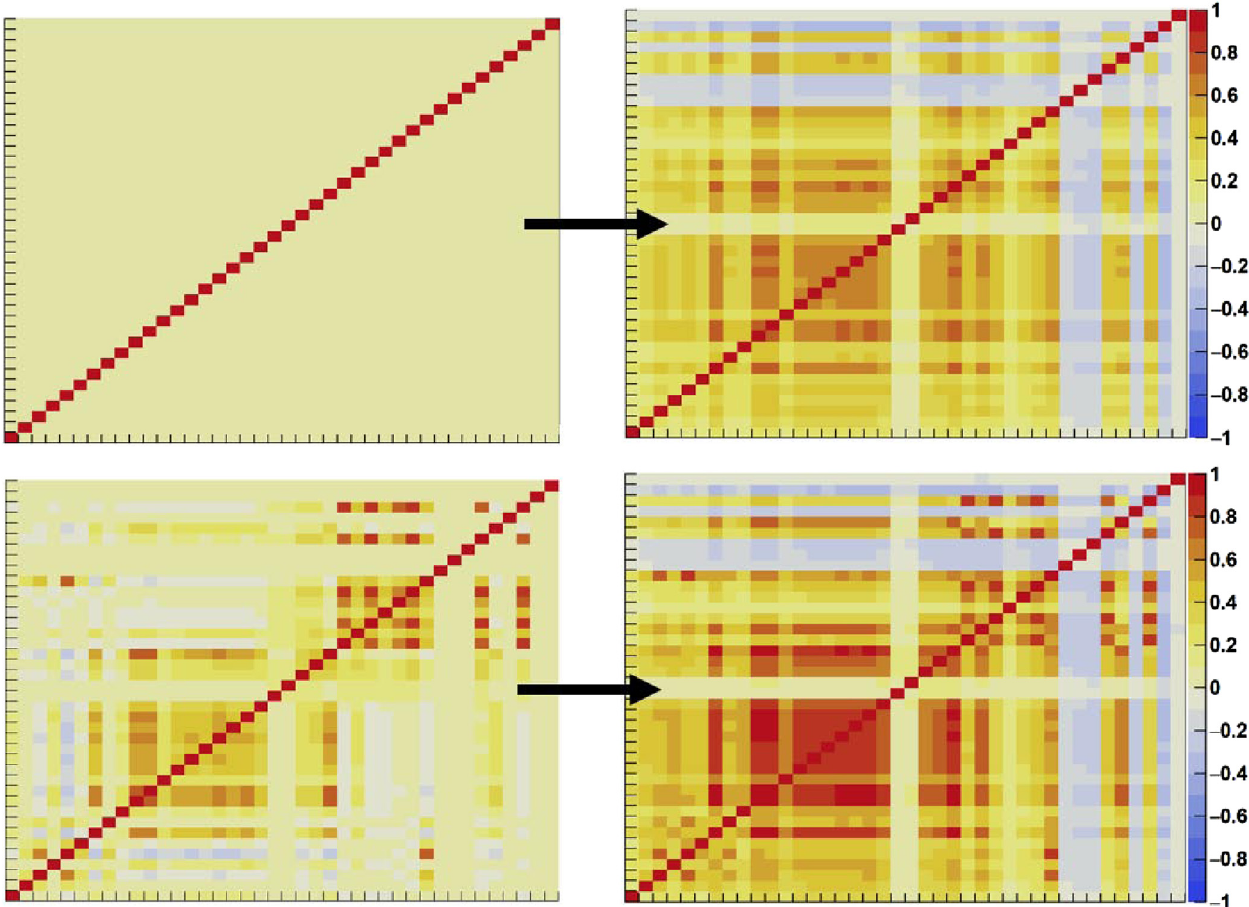
Fig. 11. On top, the correlation matrix of the N ð A Þ through the absolute normalization (right). On the bottom, the N ð A Þ through the absolute normalization (right). The analytic Y ( A ) correlation matrix (bottom right) is a combination of the effect of the normalization alone (top right) and the initial N ð A Þ identical to Figure 12